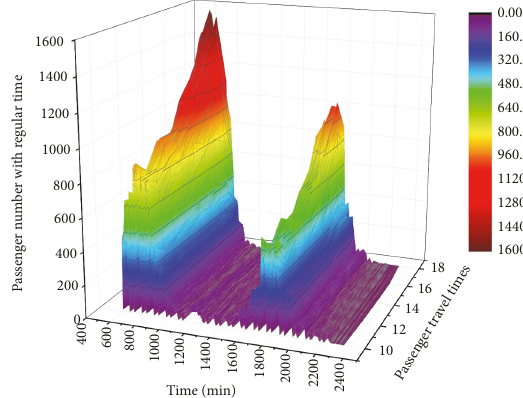
Figure 4: Passenger number variation with regular travel time (X axis) for different time (Y axis) and travel times (Z